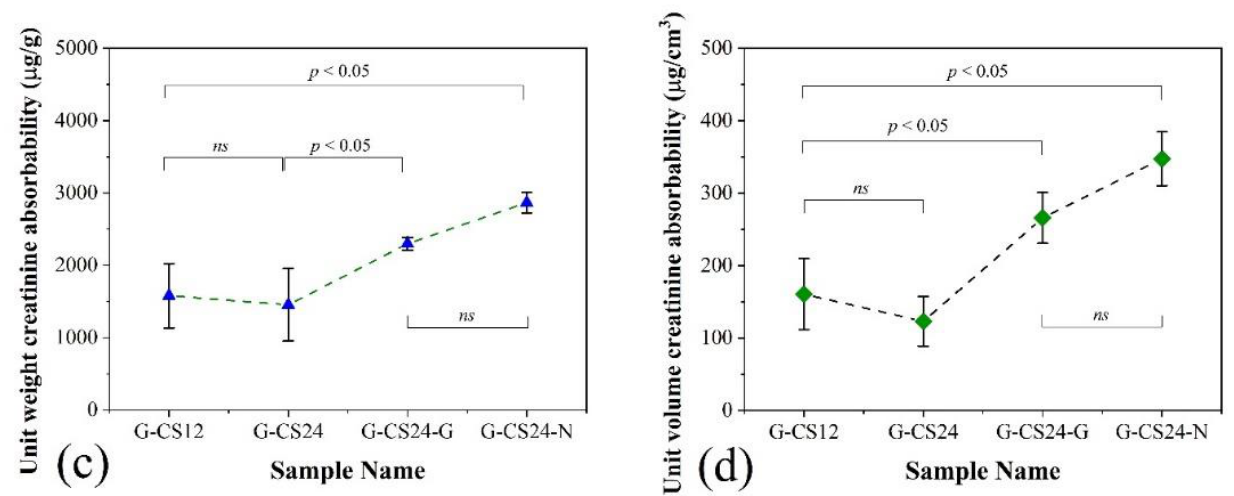
Figure 8. The comparison of unit ( a , c ) weight and ( b , d ) volume absorbability on the ( a , b ) albumin-bound indoxyl sulfate and ( c , d ) creatinine between the PCL/CS porous monoliths. (N = 3, ns = no significant difference).